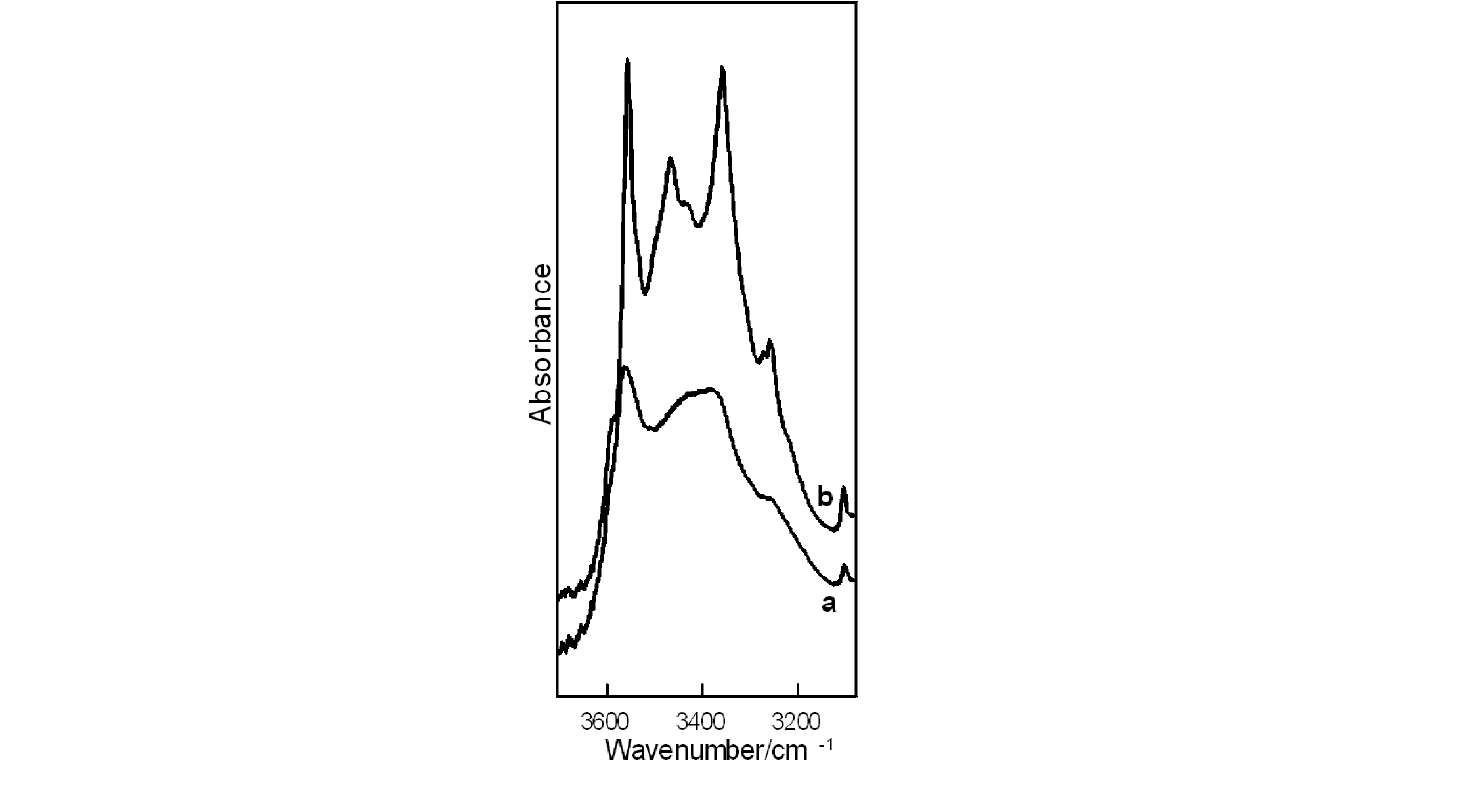
Fig. 4 The O{H stretching region in (a) RT and (b) LNT IR spectrum of K 3 (sac) 3 ¢ 2H 2